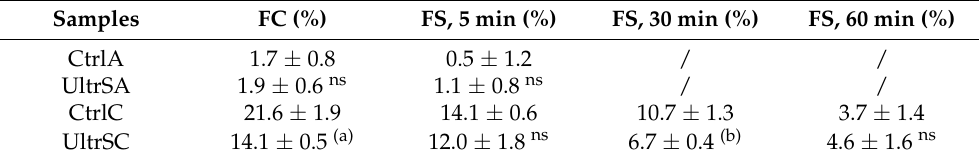
Table 3. Foaming capacity (FC) and foam stability (FS) of almond and coconut proteins.